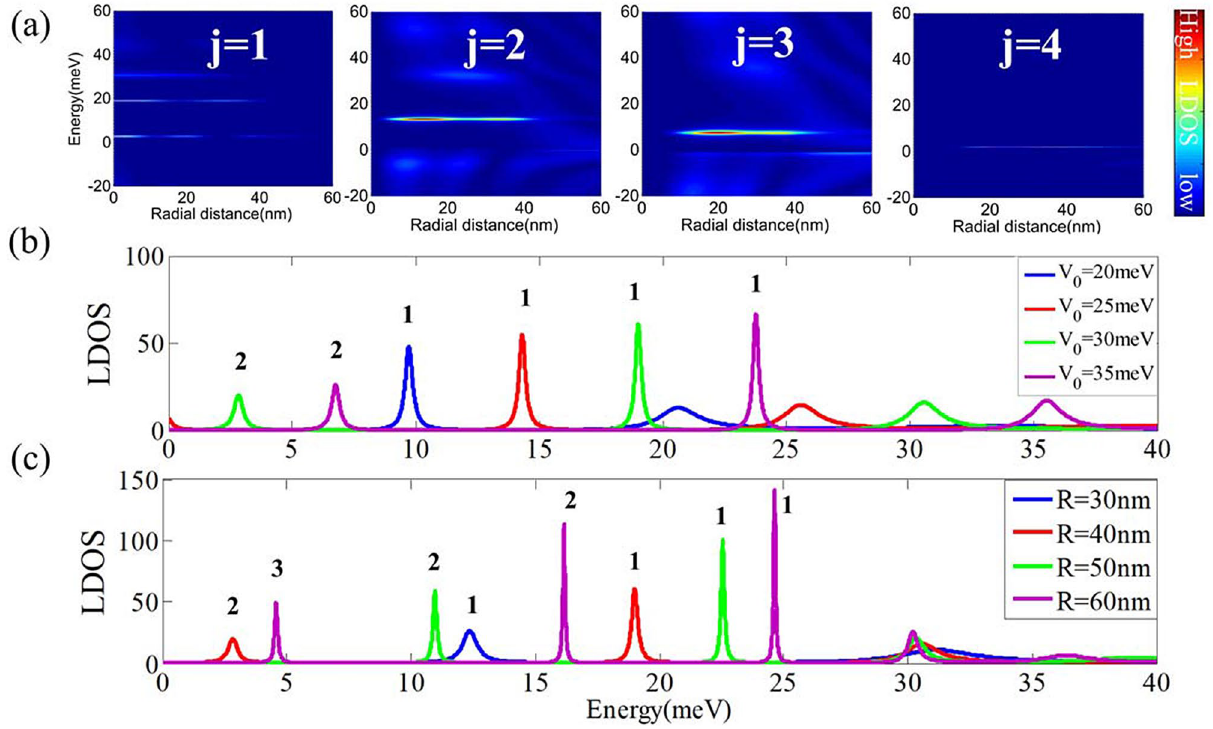
40 nm, = 1, 2, 3, 4 . The QBSs energy levels = 1 40 nm BLG quantum dot for the j = = 20 meV = 30 meV BLG quantum dot for = 30 nm =